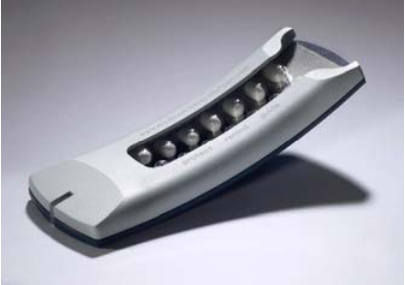
Figure 2. The Helping Hand TM (HH) (Bang & Olufsen Medicom,